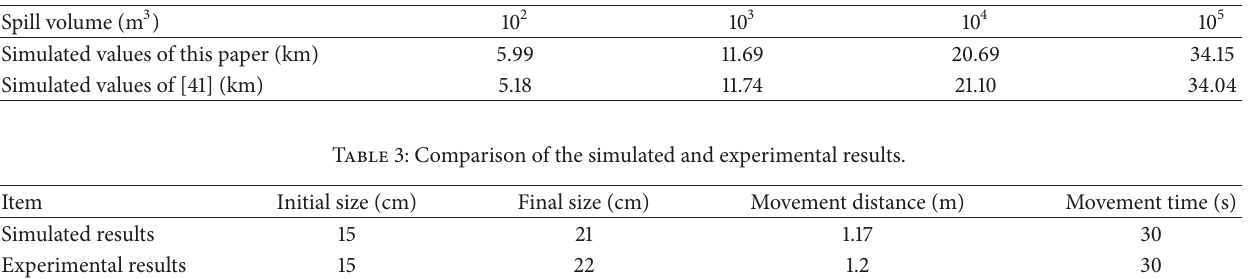
Table 2: Comparison of the minor axes scales of the oil slick.